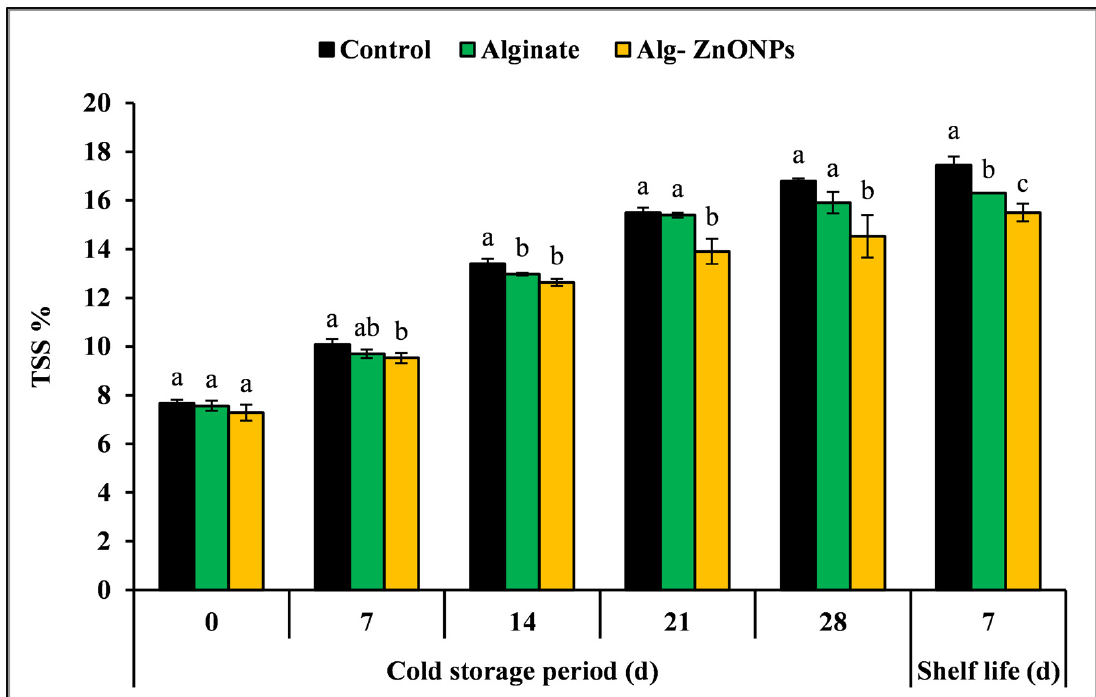
Figure 10. Effect of Alg–ZnO NPs on total soluble solids (TSS) of “Kiett” mango fruits during cold storage and shelf life; vertical bars represent the standard error (SE). Bar marked with the same letter in each sampling date are not significantly different with 95% confidence according to Duncan’s multiple range test.